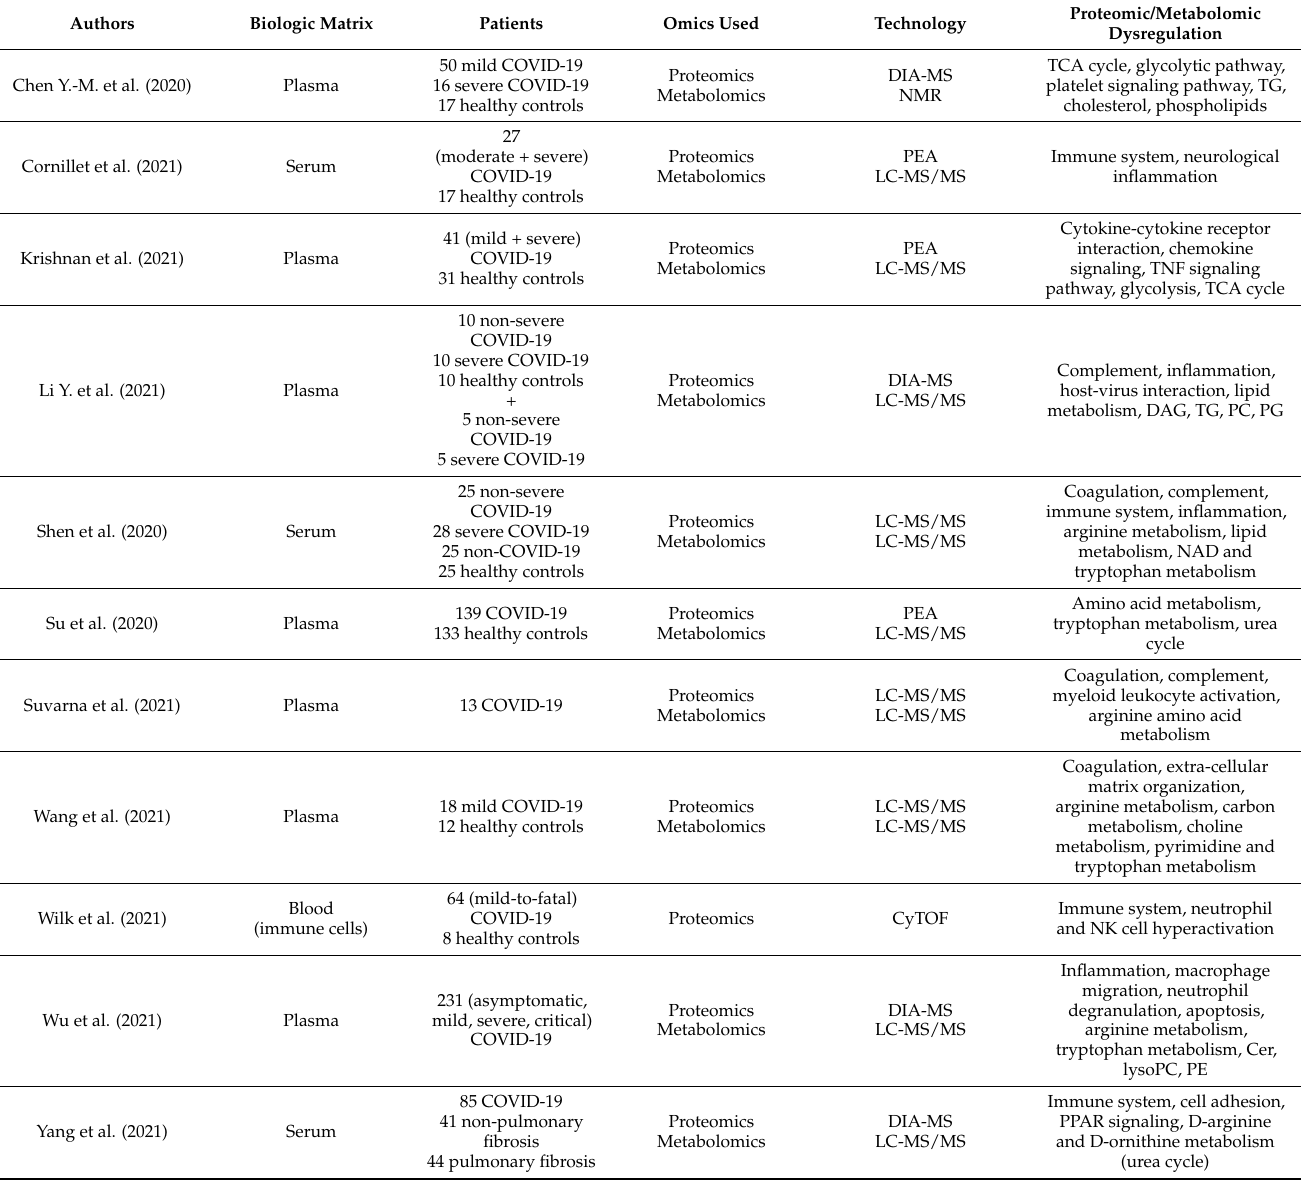
Table 3. Summary of the main characteristics of the multiomics publications containing proteomics and/or metabolomics studies related to COVID-19